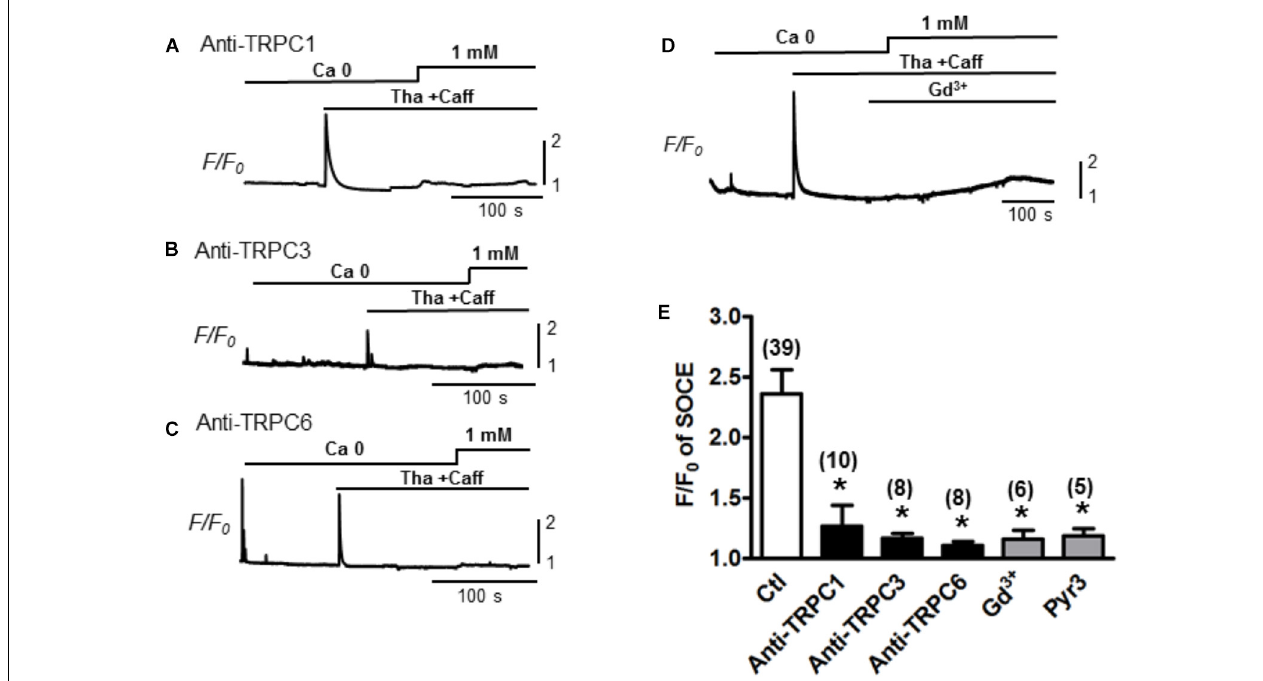
FIGURE 2 | Store-operated Ca 2 + entry inhibition by functional antibodies or inhibitors of TRPCs. (A–C) Representative traces of Ca 2 + fluorescence ( F/F 0 ) recorded from myocytes pre-treated with TRPC channel antibodies for 30 min before recording. SOCEs were evaluated using a standard protocol (i.e., 0 Ca + Tha + Caff). (D) A representative trace of SOCE after pretreatment with Gd 3 + 1 mM for 100 s. (E) A bar graph summarizing the effects of the TRPC antibodies and Gd 3 + on SOCE (Ctl: 2.4 ± 0.2, TRPC1 Ab: 1.4 ± 0.2, TRPC3 Ab:1.2 ± 0.2, TRPC6 Ab: 1.1 ± 0.1 and Gd 3 + :1.2 ± 0.1, Pyr3: 1.2 ± 0.1, Student’s t -Test), suggesting TRPC channels account for